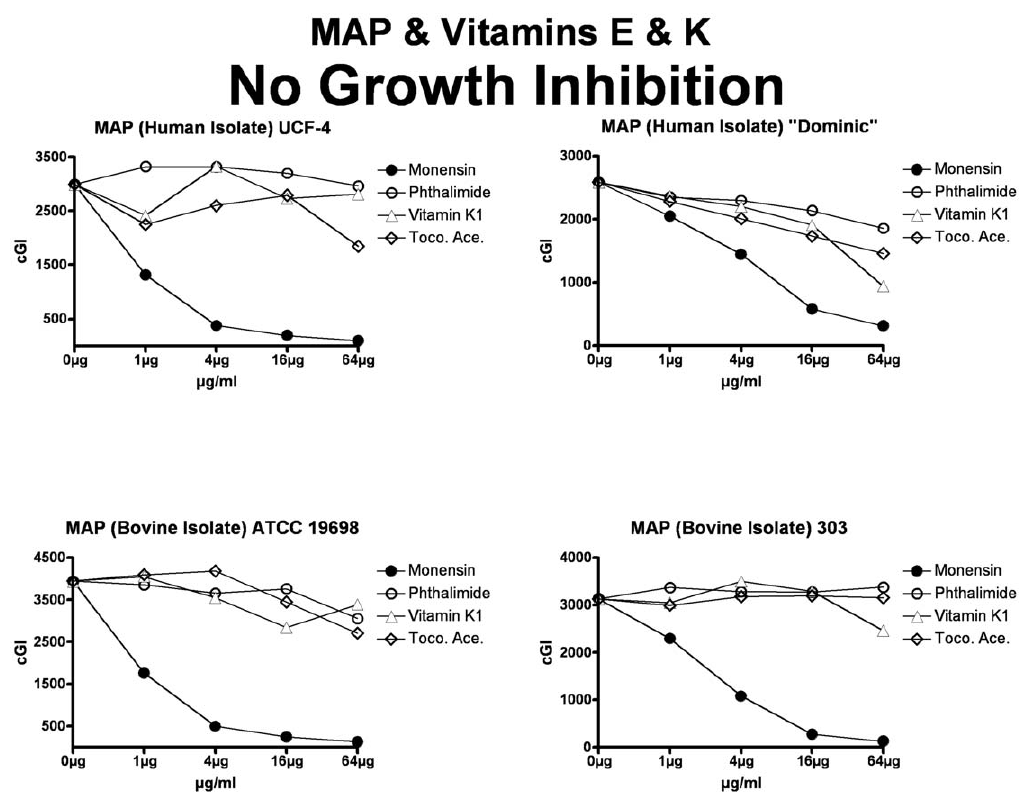
Figure 4. Neither vitamins E nor K inhibit MAP (other than limited inhibition by vitamin E on Dominic.) The inhibitory control is Monensin, and the non-inhibitory control is Phthalimide. cGI=cumulative Growth Index.